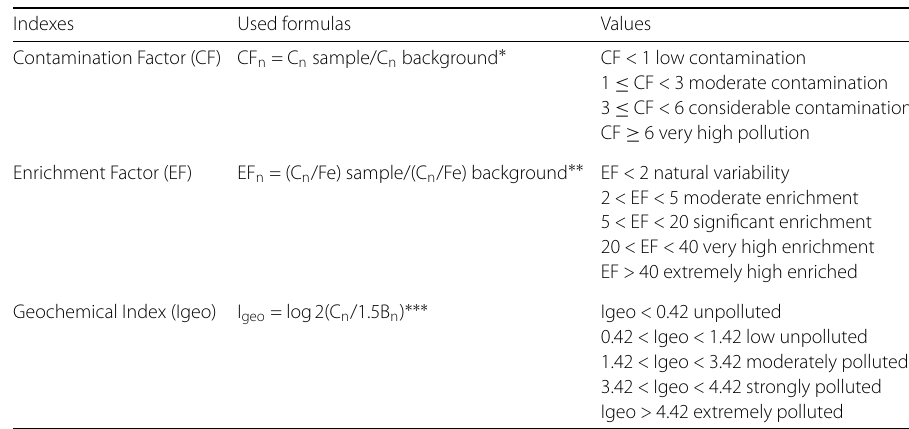
Table 1 Pollutions indices [33] Indexes